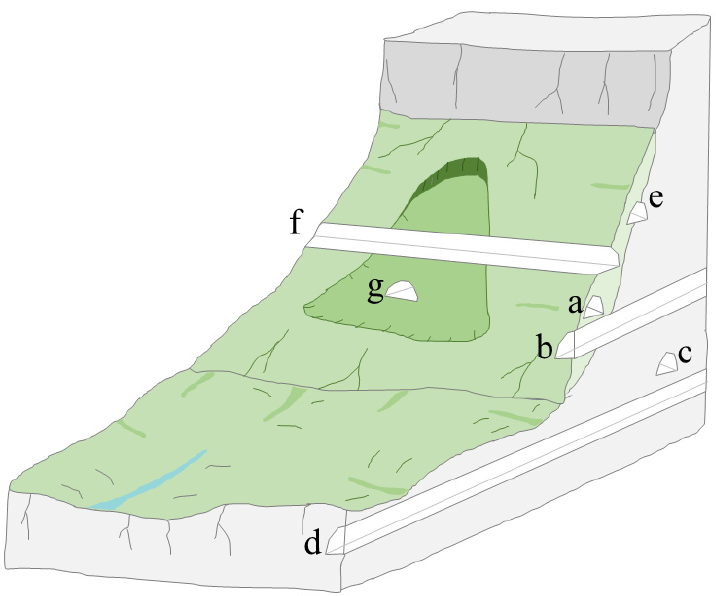
Figure 15. Tunnel–landslide spatial relationship. (a~g: The spatial relationship between a landslide and a tunnel.)